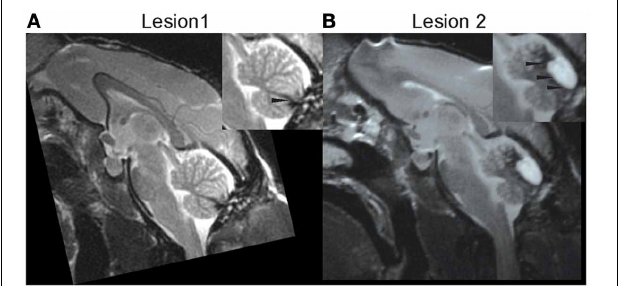
FIGURE 4 | High resolution midline sagittal MRI slice after lesion 1 (A) and after lesion 2 (B). Adopted from Ignashchenkova et al. (2009). Further technical details are provided